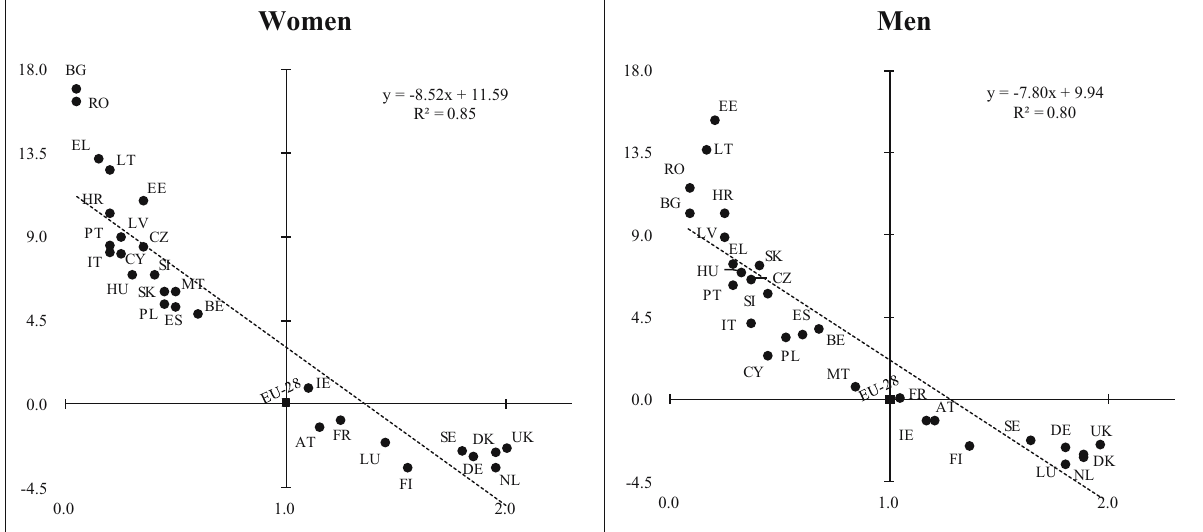
2019, regardless of how it is expressed, in percentage points or as a percentage. Two negative regression coe ffi - cients are obtained and a lower R 2 is obtained in the digital gender gap calculated as the di ff erence in the per - centages of Internet use by men and women. Figure 8 contains information on the digital gender gap in online shopping, through the ICT - PURCHASE indicator.